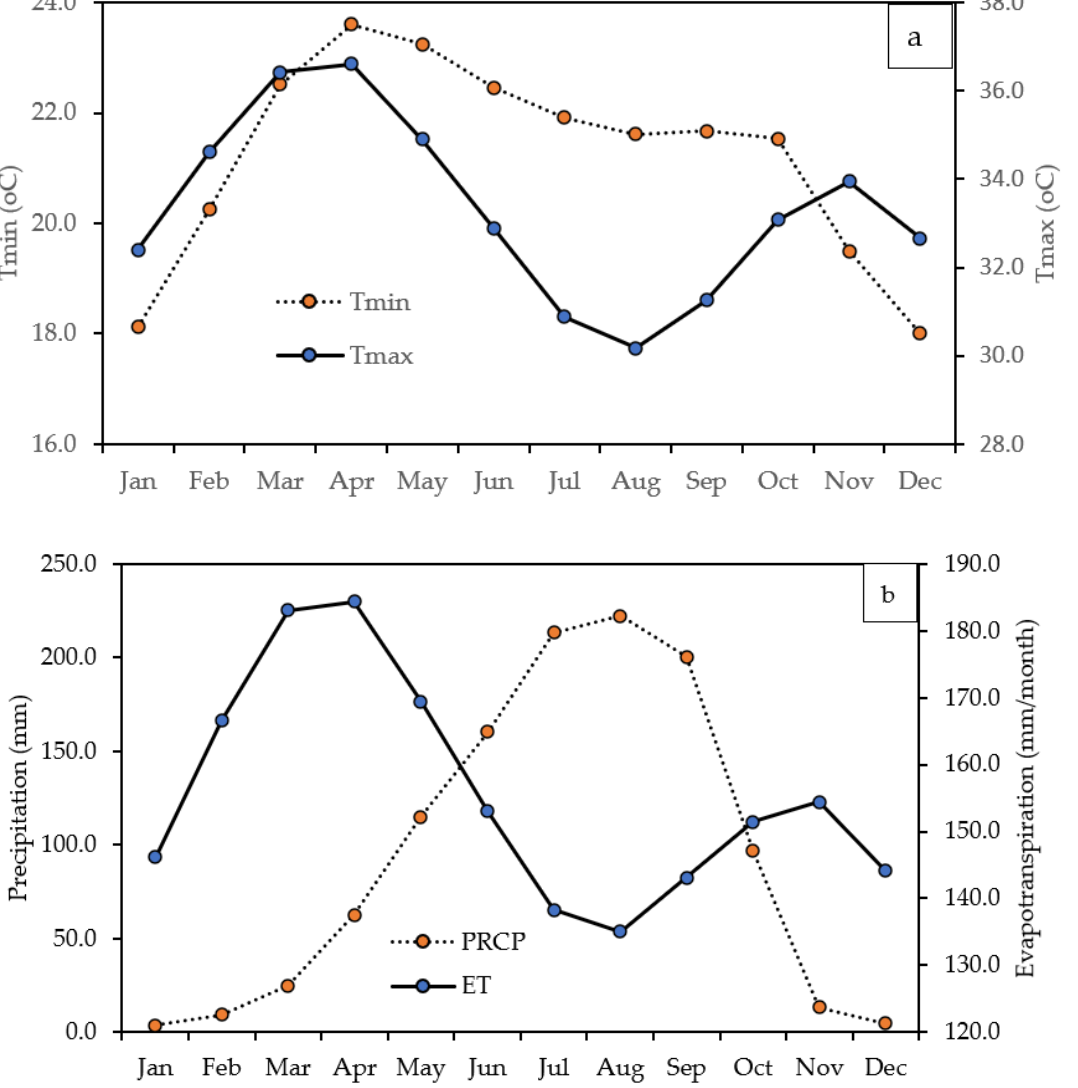
Figure 2. Long-term historical average monthly distribution of ( a ) T min and T max; and ( b ) precipitation (PRCP) and evapotranspiration (ET) of the study area.